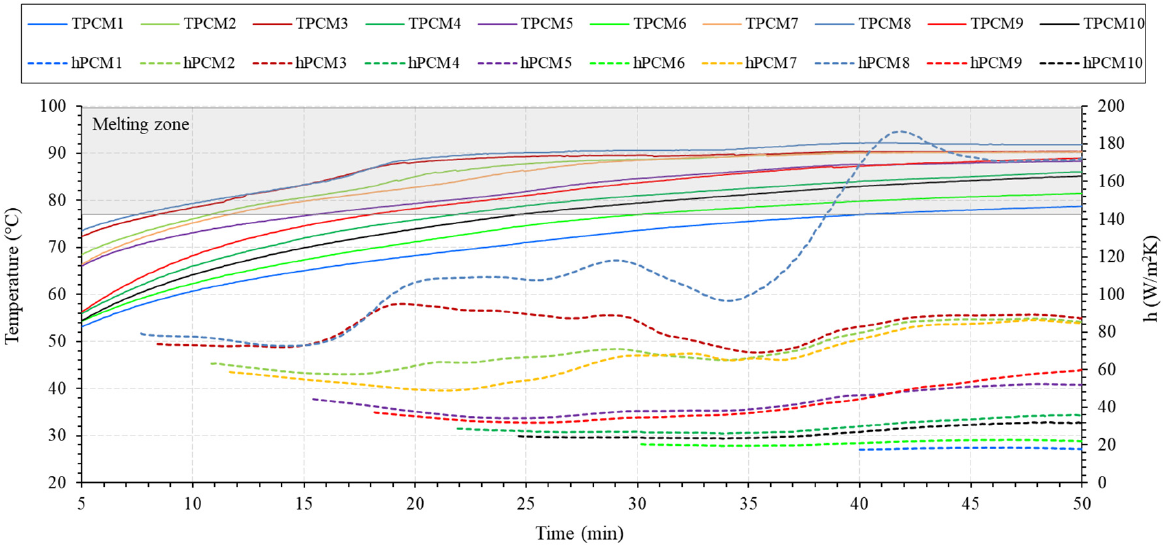
Figure 5. Variation of temperature and local heat transfer coefficient in different measurement points.